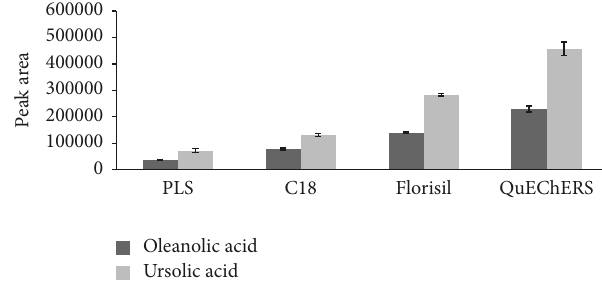
Figure4:Peakareaoftheguavaleavesamplesindifferentextraction